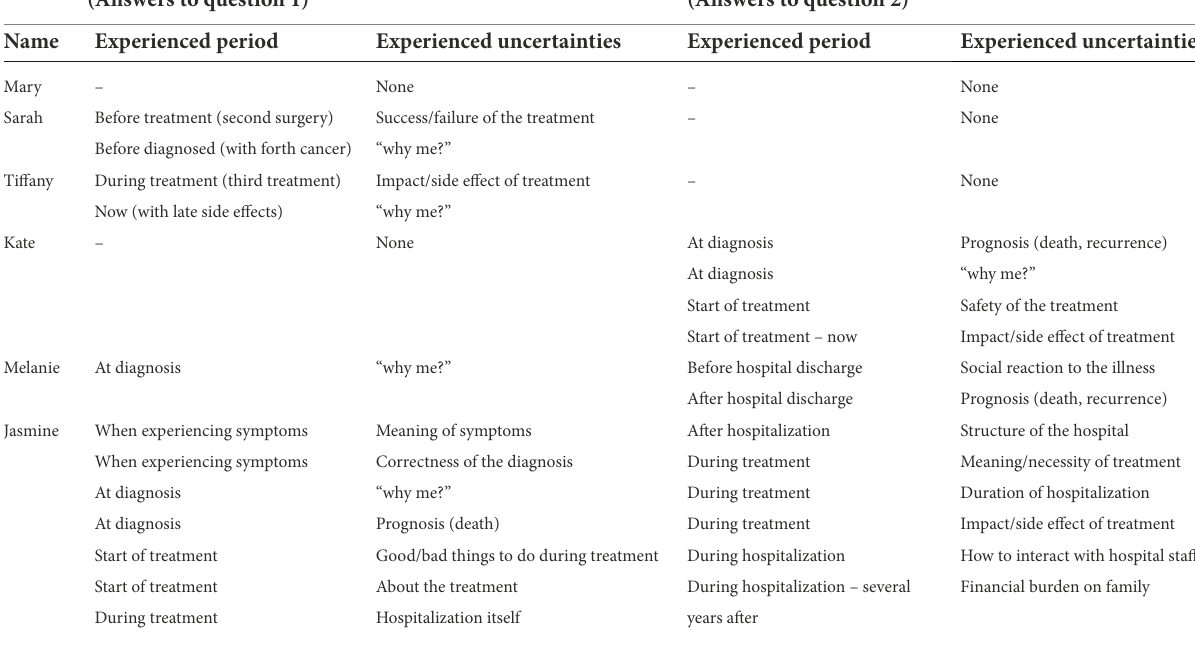
TABLE 3 Experienced